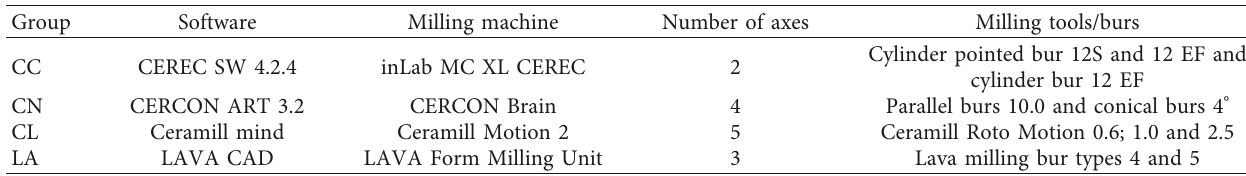
T ABLE 2: Software and milling specifications for each CAD/CAM system.